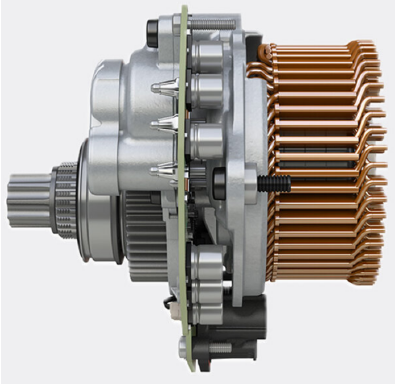
Figure 27. Bosch motor adopting hairpin winding